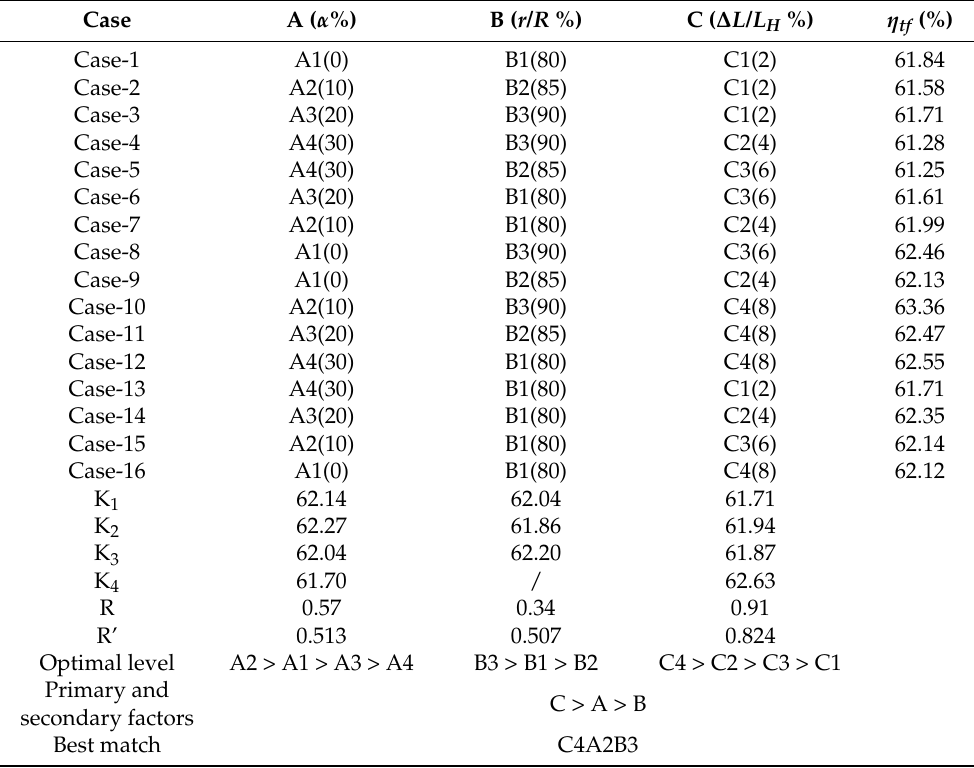
Table 2. Orthogonal